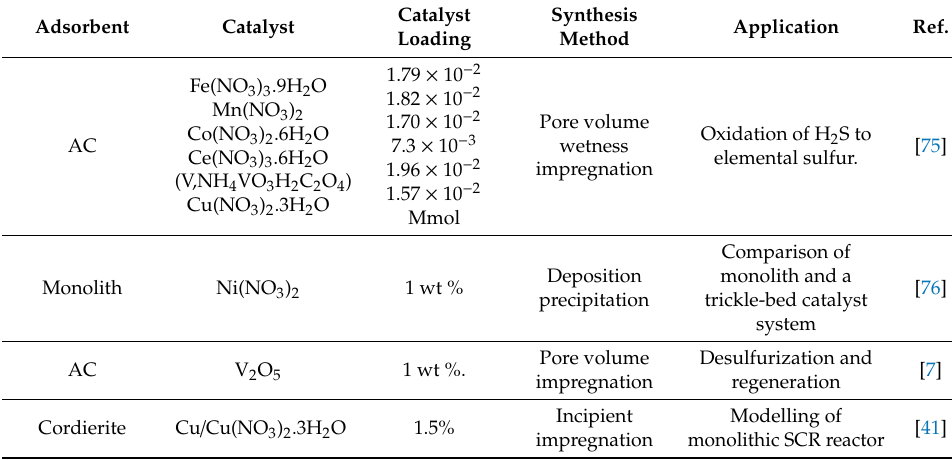
Table 3. Reviewed catalyst loading on